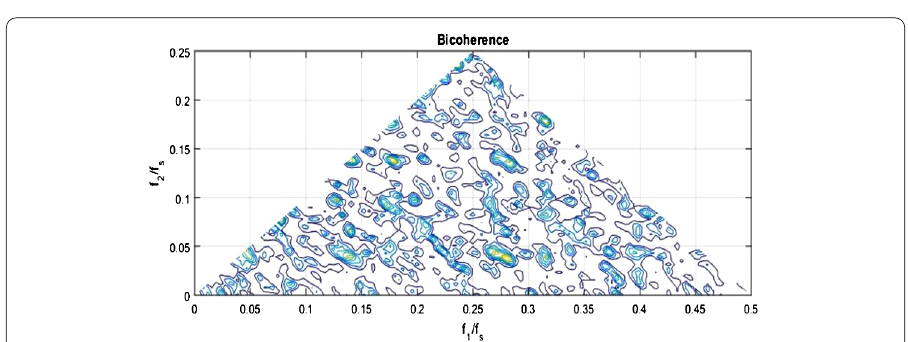
Figure 7 Bicoherence of the state x 1 of the fractional-order system.